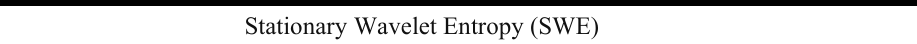
Table 3. Algorithm of Stationary Wavelet